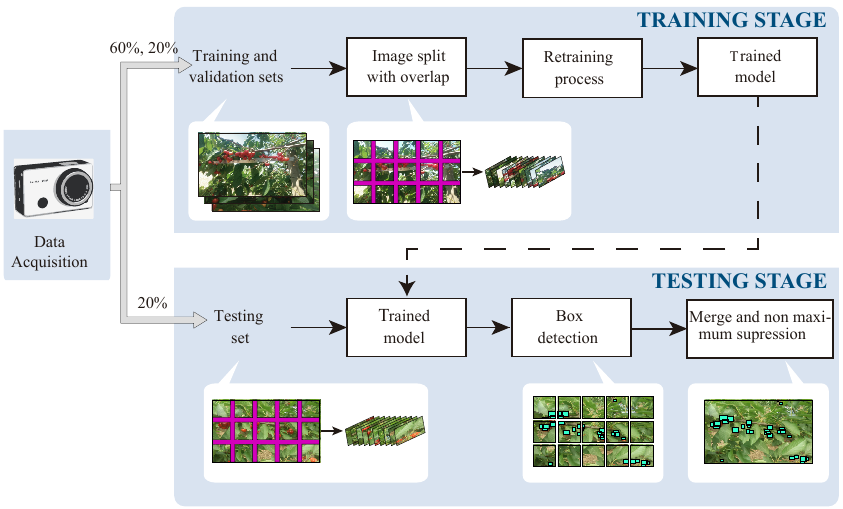
Figure 1. General architecture of the training and validation stages.